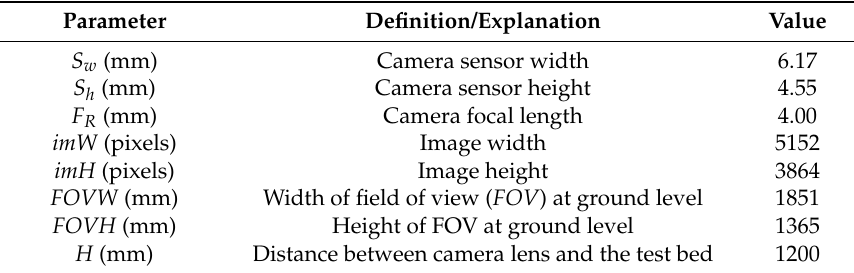
Table 1. Key parameters of experimental setup.